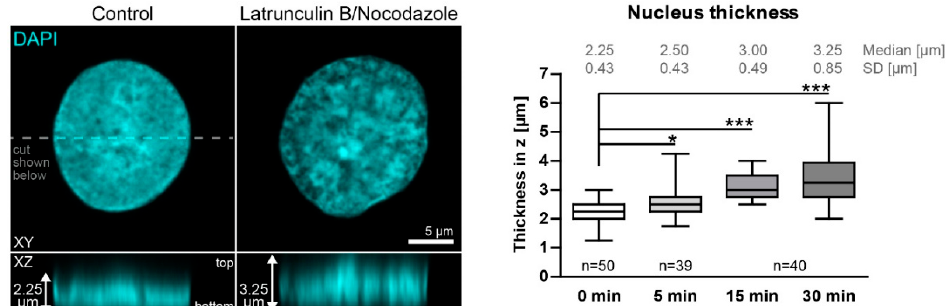
Figure A2. Nuclei enlarge in Z upon actin and microtubule inhibition. The fluorescence images depict a DAPI-stained nucleus of a methanol fixed HaCaT cell without any added inhibitor at left (Control) in comparison to that of a HaCaT cell that had been treated for 30 min with 3 µM latrunculin B and 20 µM nocodazole in XY (top) and XZ (bottom). To measure nucleus thickness, confocal planes with DAPI signal were identified, and the distance from the lowest to the highest plane was measured (2.25 µm versus 3.25 µm in the depicted examples). Note that it is not necessary to correct for skewness, since the bottom signal is mainly flat because of the glass surface below. The whisker box plot (whiskers from minimum to maximum; three independent experiments on different days; n values corresponding to cell numbers) on the right reveals that nuclear thickness increases significantly during inhibitor treatment. Kruskal–Wallis test is significant with a p < 0.0001 and Dunn’s multiple comparison post-test shows significant differences as indicated in the graph (* p < 0.05, *** p < 0.0001).